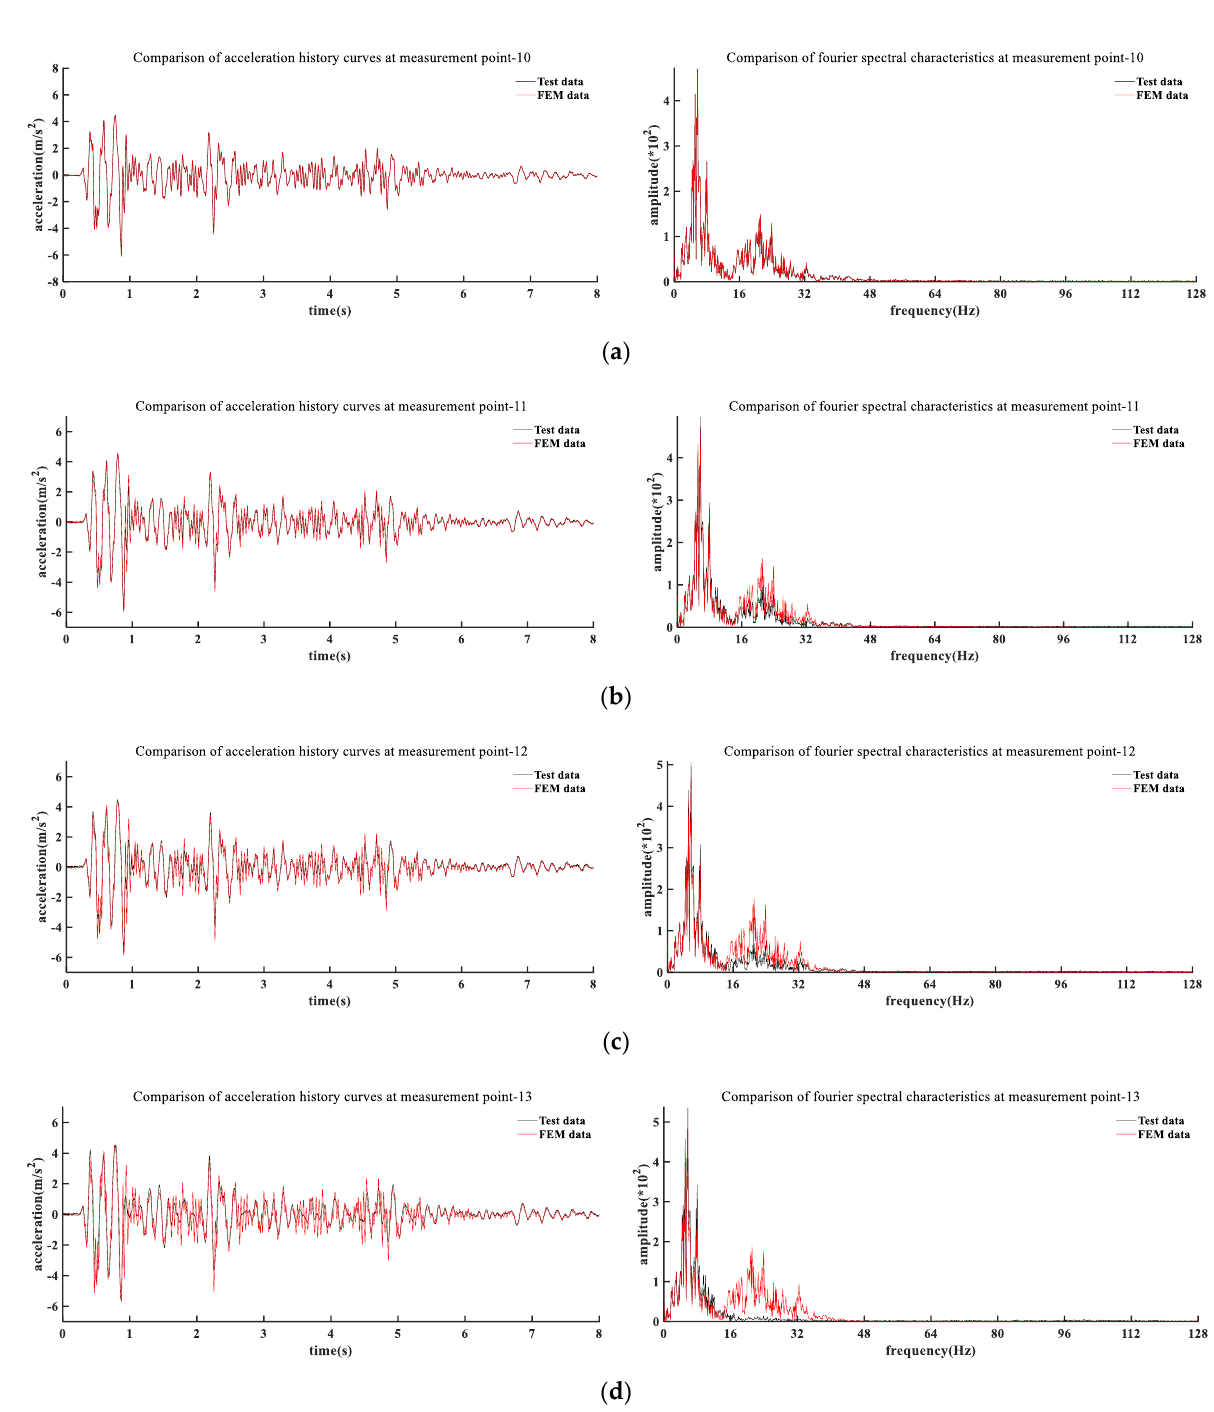
Figure 10. Comparison results of the isolation storage tank under El Centro (X, 0.5 g): ( a ) measuring point 11; ( b ) measuring point 11; ( c ) measuring point 12; ( d ) measuring point